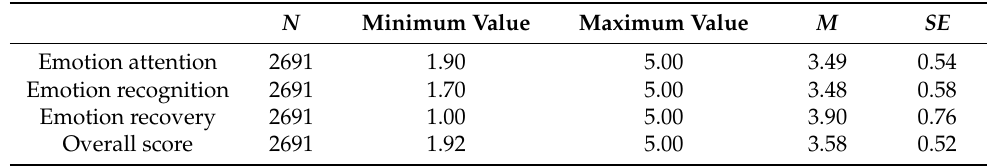
Table 4. Adolescents’